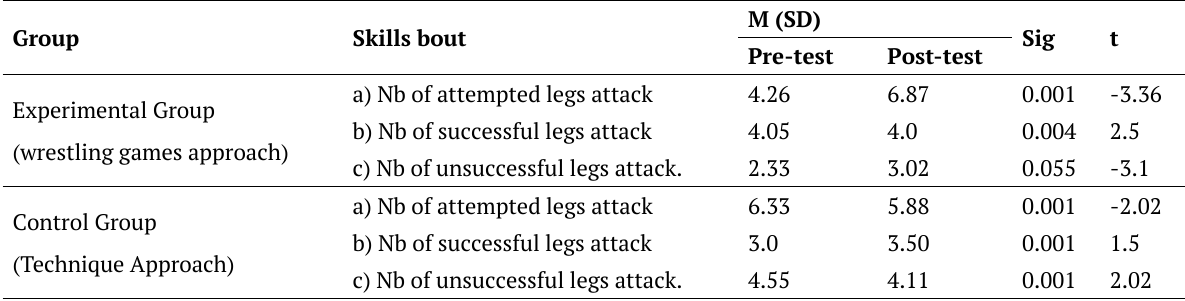
Table 3. The effect of two teaching methods on legs attack performance in a wrestling bout (n = 20)